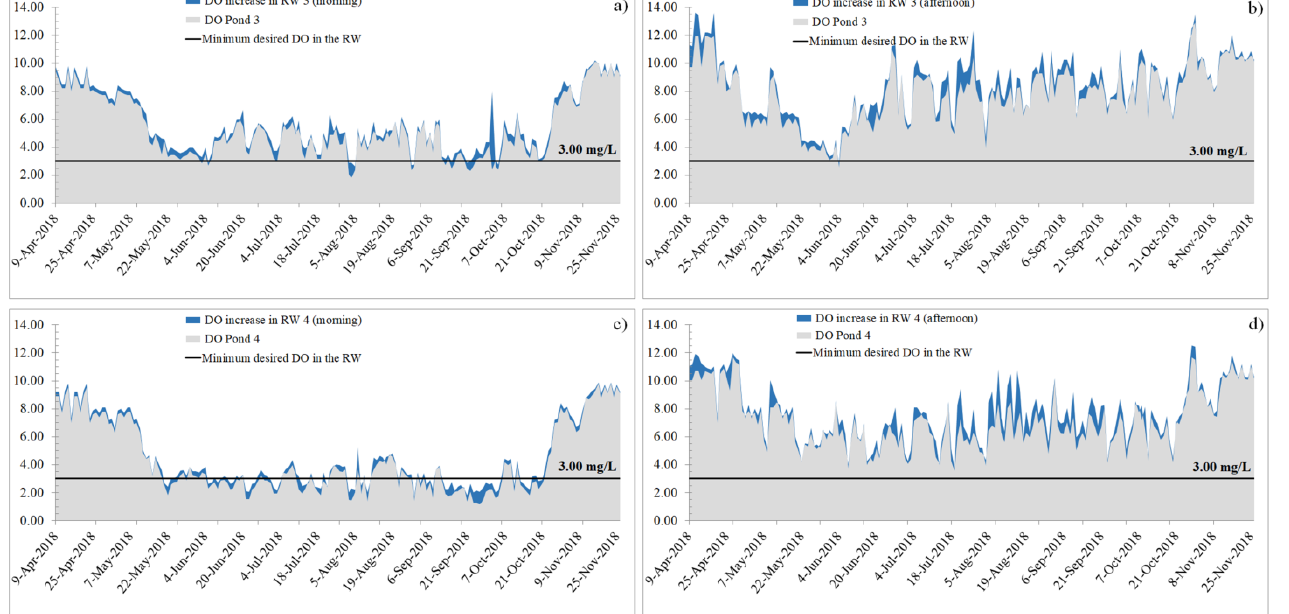
Figure 3. Illustration of the early morning (left) and afternoon (right) dissolved oxygen concentrations in the pond (light grey) and inside growout raceways (blue) RW3 ( a , c ) and RW4 ( b , d ). The blue area above the light grey area indicates how much oxygen the IPRS aeration device added to the water at the entrance of the raceway, keeping dissolved oxygen levels inside the raceway at or above 3 mg/L (minimum desired level), seldom below 2 mg/L, and regularly above the outside pond water, 2018. DO = Dissolved oxygen mg/L.